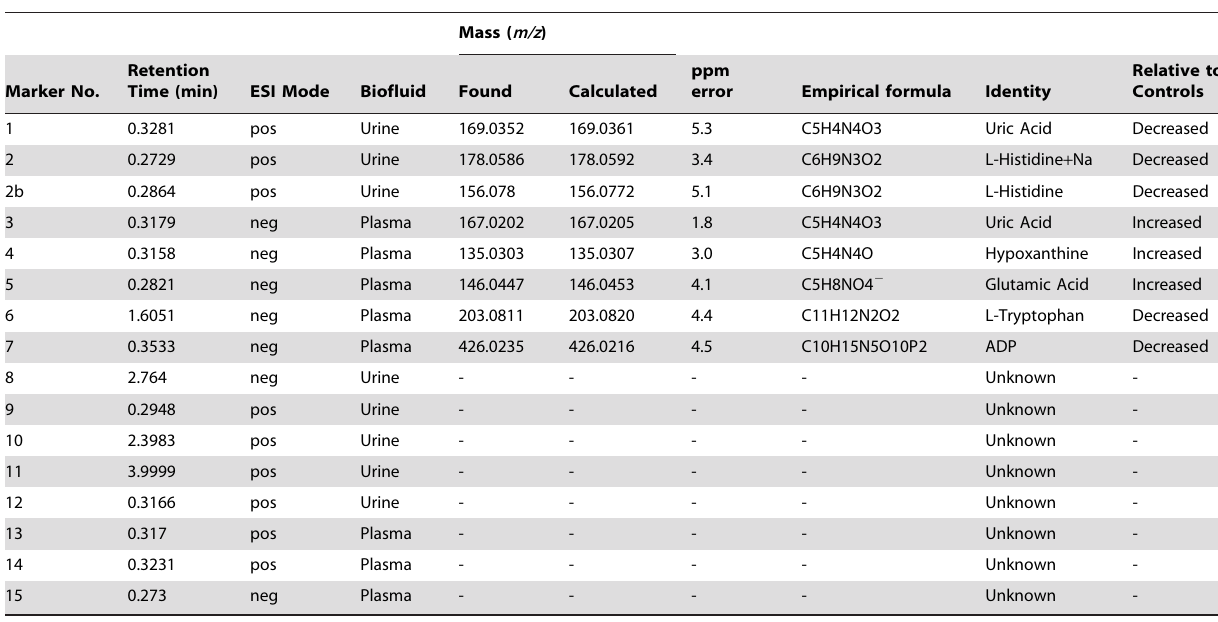
Table 1. Identification of urinary and plasma biomarkers in severe pneumonia cases.